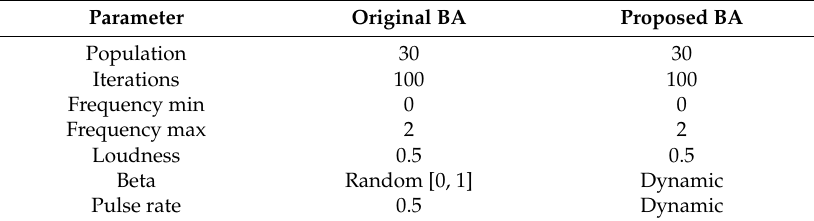
Table 6. Parameters for the BA method original/proposed.